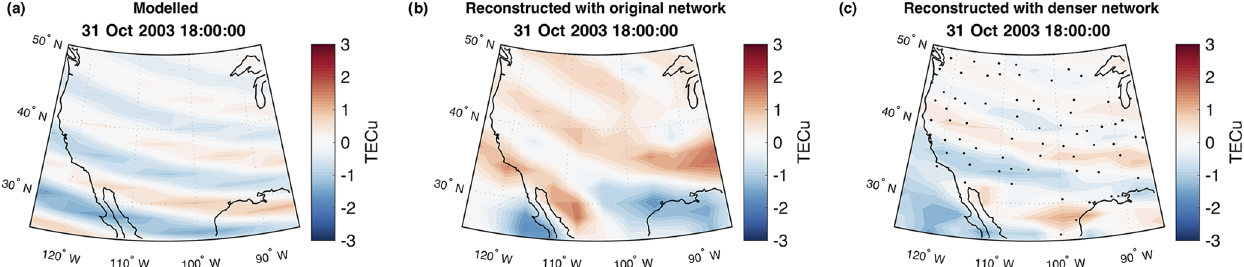
Figure 8. The modelled LSTID vTEC (a) and inversions from the simulated data, (b) and (c) , with a 1h running mean background subtracted. Panel (c) uses a denser network than the real inversion, where the receiver locations of the network are indicated with black markers.